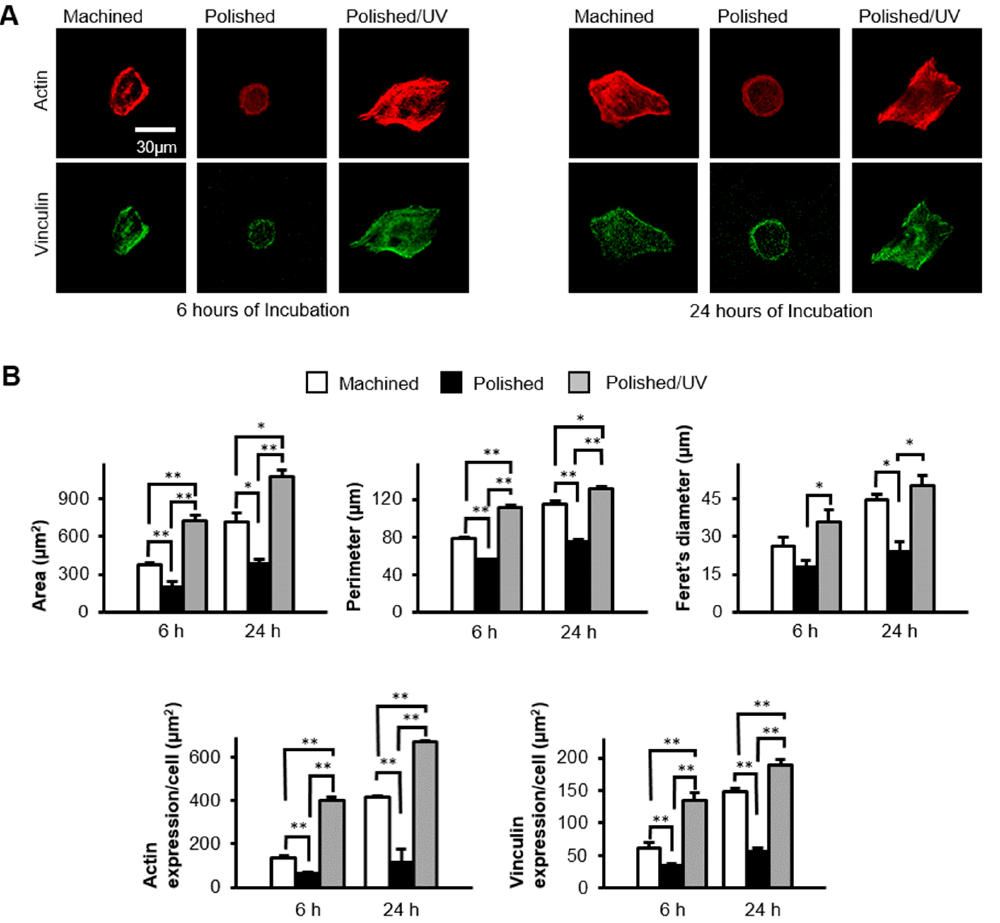
Figure 6. Spreading behavior of human epithelial cells on titanium disk surfaces during initial culture, after 6 and 24 h of seeding. ( A ) Confocal microscopy images of human epithelial cells stained with immunochemical cytoskeletal actin (red) and vinculin (green) dyes. Scale bar = 30 µ m. ( B ) Histograms of cytomorphometric parameters, constructed from the images in panel ( A ) (* p < 0.05, ** p < 0.01).